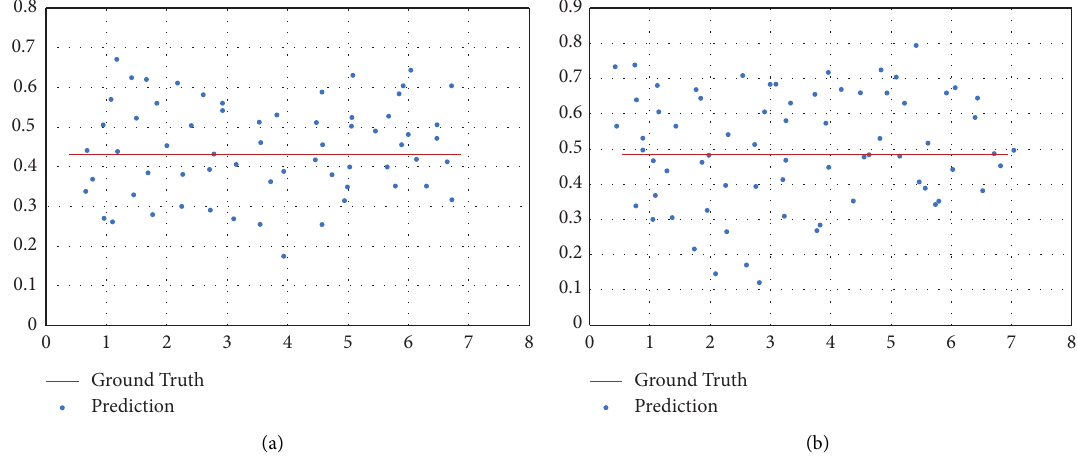
Figure 10: UWB positioning results in the presence of NLOS. (a) Performing NLOS. (B) Without performing NLOS.